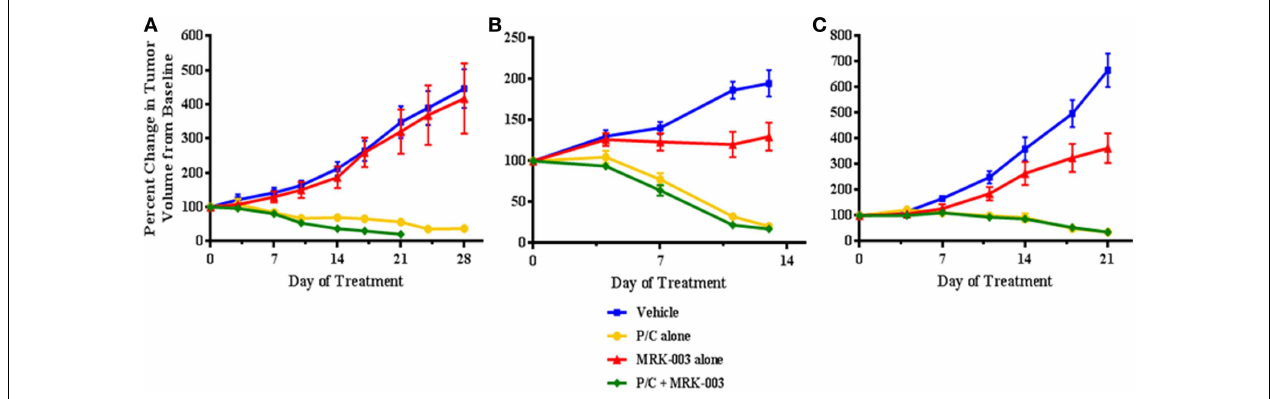
anti-tumor effect of treatment with MRK-003 alone was observed in OV3 (B) and OV4 (C) xenografts ( p < 0.05). P/C alone and P/C + MRK-003 were equally effective in significantly reducing tumor growth of OV2 (A) , OV3, and OV4 xenografts ( p < 0.01).Tumor volumes were measured twice weekly. Error bars represent the standard error of the mean.